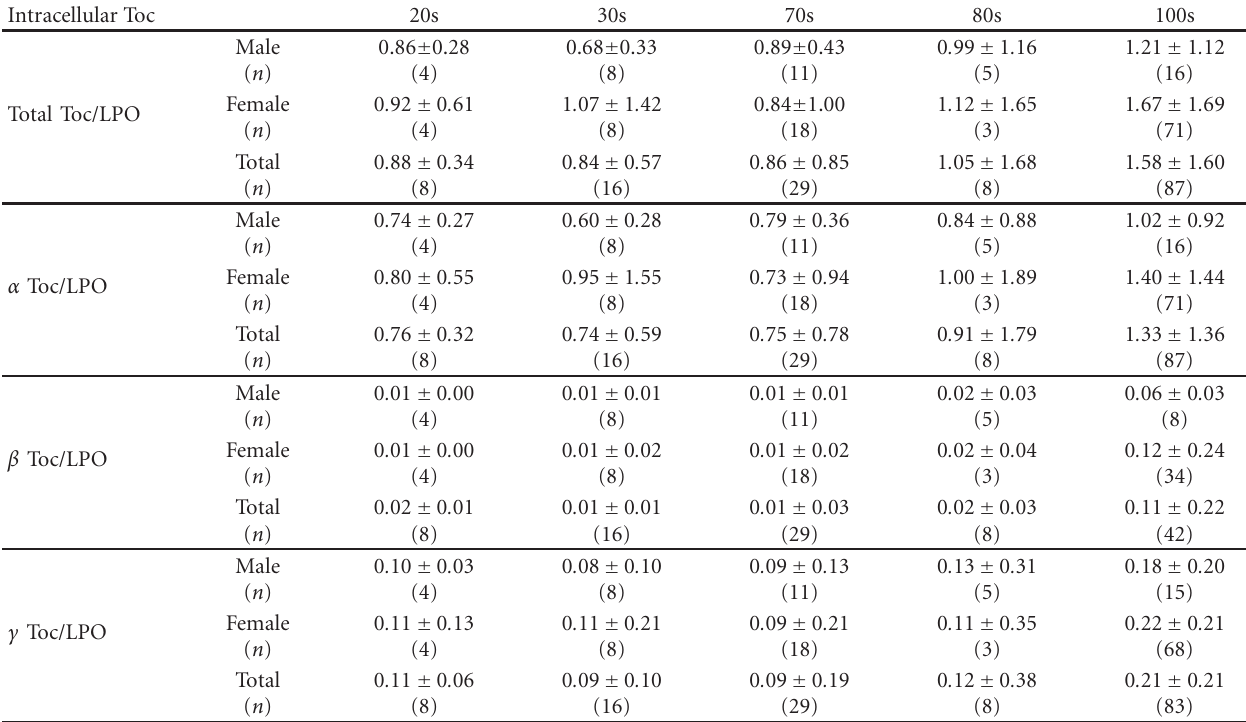
Table 6: Intracellular tocopherol: lipid peroxide ratios across age strata.